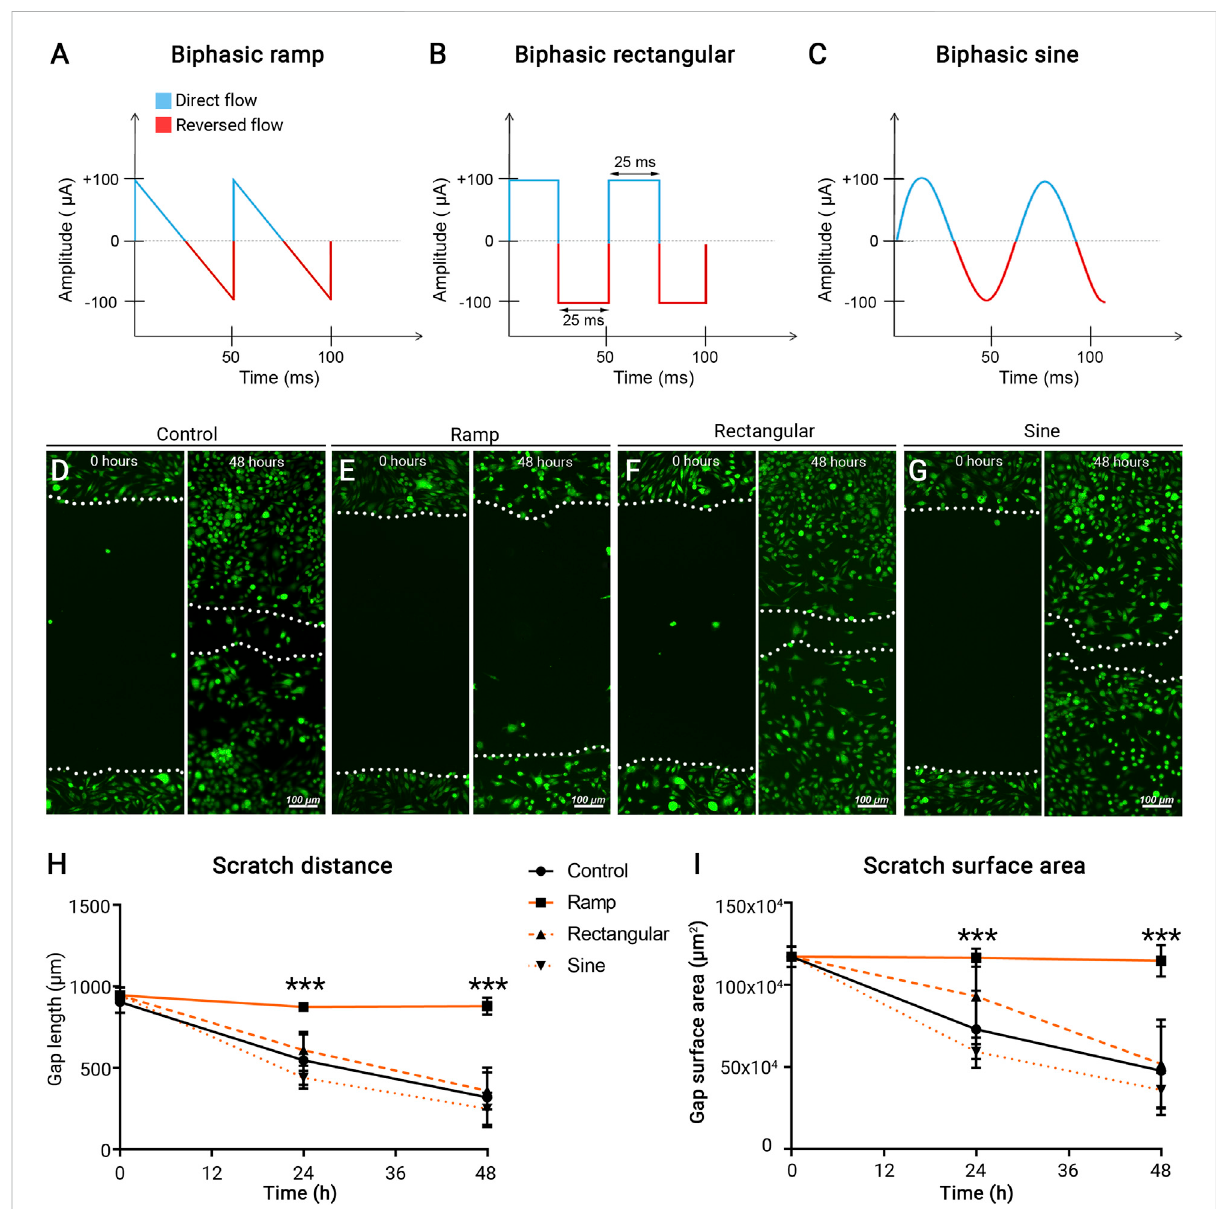
FIGURE 1 Microcurrent ES of ramp waveform inhibits BV-2 cell migration. (A – C) Schematic representation of different ES waveforms: (A) Ramp; (B) Rectangular; (C) Sine. (D – G) Photomicrographs of migratory BV-2 cells stained by a fl uorescence vital dye Calcein AM (green) in the scratch assay and assessed at 0 and 48 h post scratching. Cells were cultured under a control condition (D) or subjected to ES of ramp (E) , rectangular (F) , or sine (G) waveform. Scale bar: 100 µm. (H,I) Quantitative analysis of scratch distance (H) and scratch surface area (I) . n = 8 cultures/group; Statistical signi fi cance was determined using one-way ANOVA with Tukey multiple comparisons. * p < 0.05; ** p < 0.01; value = means ±